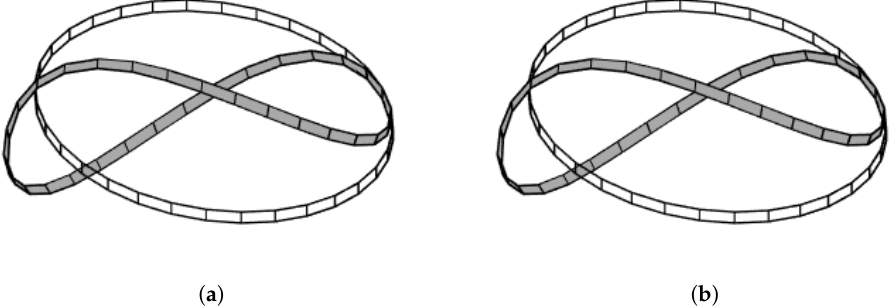
Figure 6. Ring: deformed configuration and displacement of point B for assigned load and for as- signed strain field. ( a ) Assigned load, displacement at B u 1 = 26.782; ( b ) assigned strain, displacement at B u 1 =